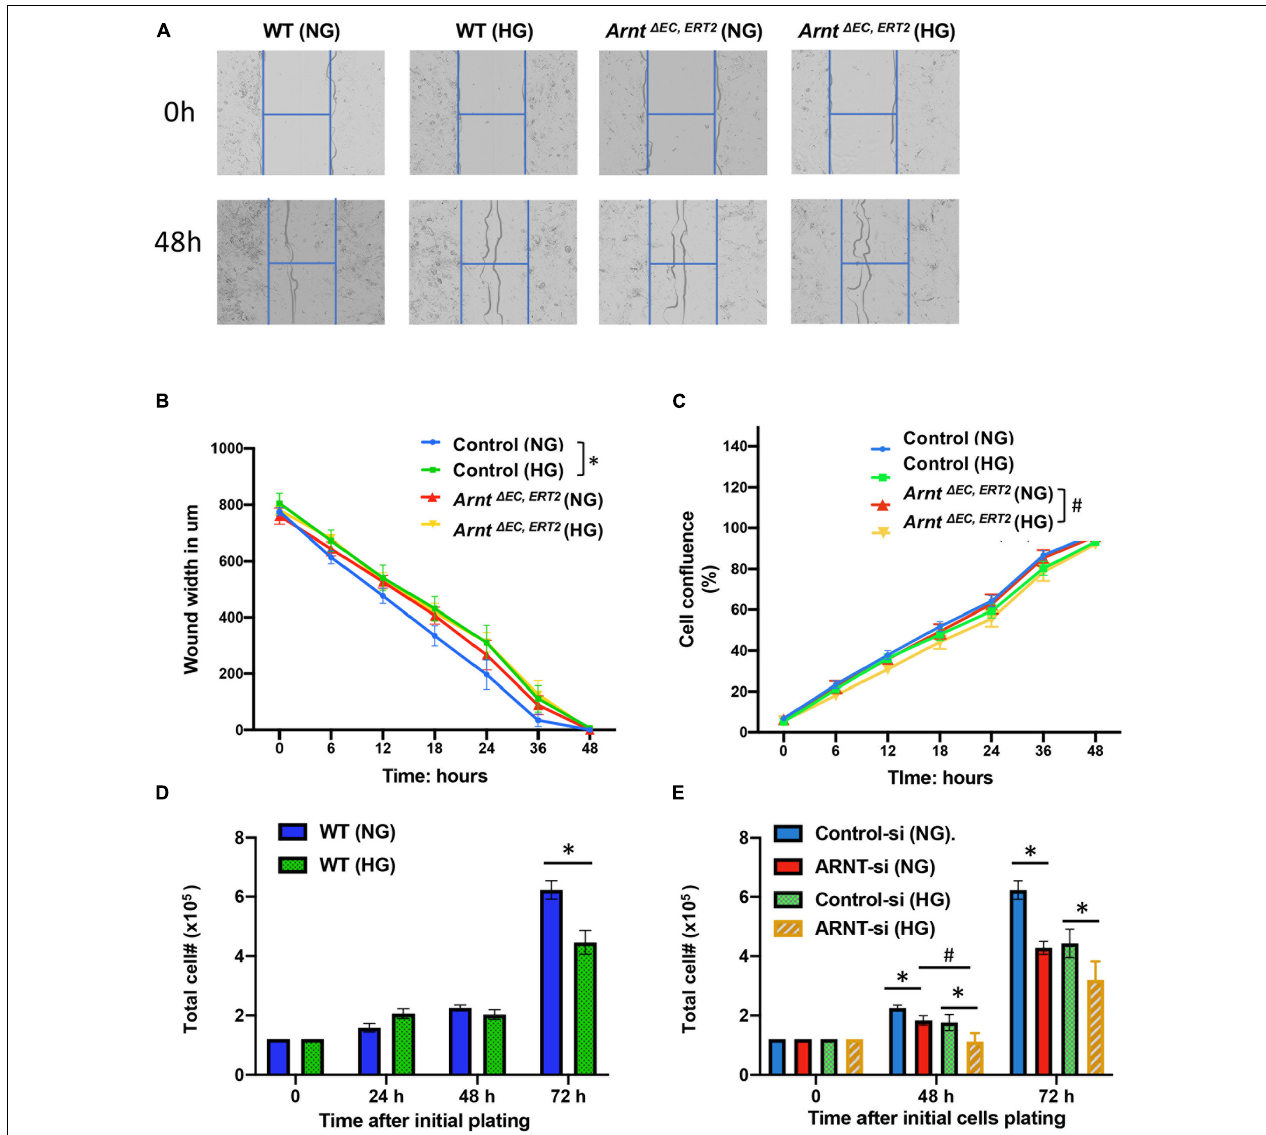
FIGURE 5 | Effect of ecARNT knockdown on high glucose-induced migration dysfunction in MMVEC and proliferation inhibition in HUVECs. (A) Representative micrographs of automatically acquired images of real-time live cells using Incucyte R (cid:13) system. Images show that compared to WT HUVECs in osmotic pressure control group (WT and NG), HUVECs with high glucose migrated more slowly P = 0.0026, corresponding statistical analysis of HUVEC migration by scratch wound healing assay. All 96-well kinetic trends were viewed at once with Incucyte R (cid:13) PlateGraph and data was exported to calculate different values shown. (B) Wound width. n = 8, * p < 0.01 vs. WT (NG). Please note, migration in HUVECs with ARNT knockdown failed to respond to high glucose exposure (C) Cell confluence%, n = 8, * p < 0.001 vs. WH (NG); # P < 0.01 vs. Arnt (cid:49) EC , ERT2 (NG). (D) High glucose-mediated reduction in WT HUVEC proliferation over time. (E) Effect of ecARNT knockdown on HUVEC proliferation over time following either normal glucose or high glucose exposure. The same number of HUVECs were seeded on Day 0 (1.2 × 10 5 ) in 6- well plate. ARNT knockdown was induced with an siRNA transfection. Data are presented as the mean ± SEM ( n = 6). ∗ P < 0.01 versus corresponding